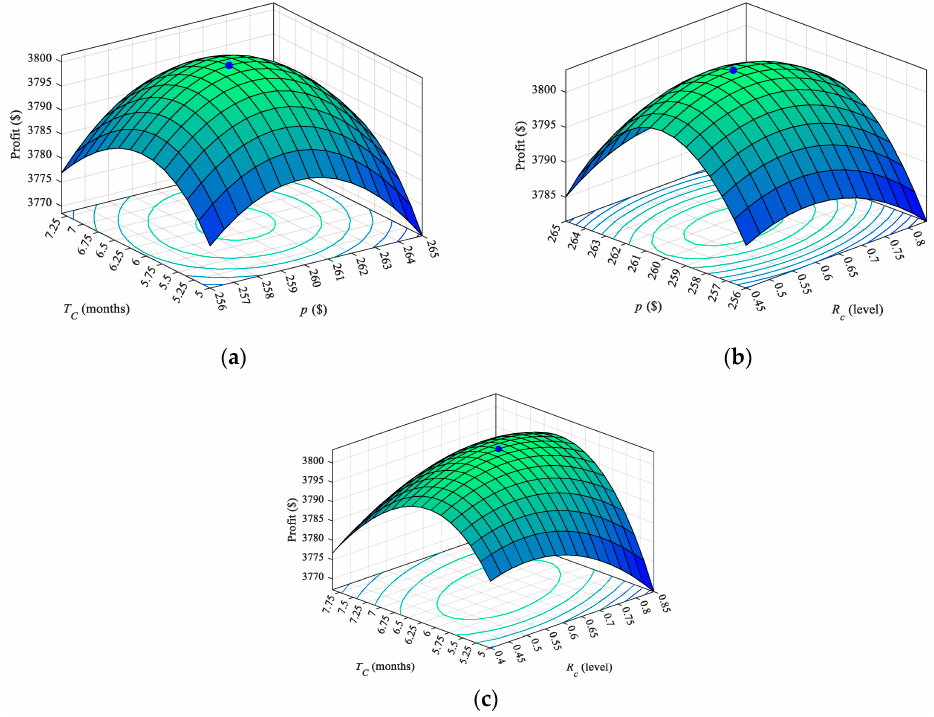
Figure 5. Profit function ( τ ) with regard to: ( a ) the selling price ( p ) and cycle time ( T C ); ( b ) the manufacturer’s carbon emission reduction level ( R c ) and selling price ( p ); ( c ) the manufacturer’s carbon emission reduction level ( R c ) and cycle time ( T C